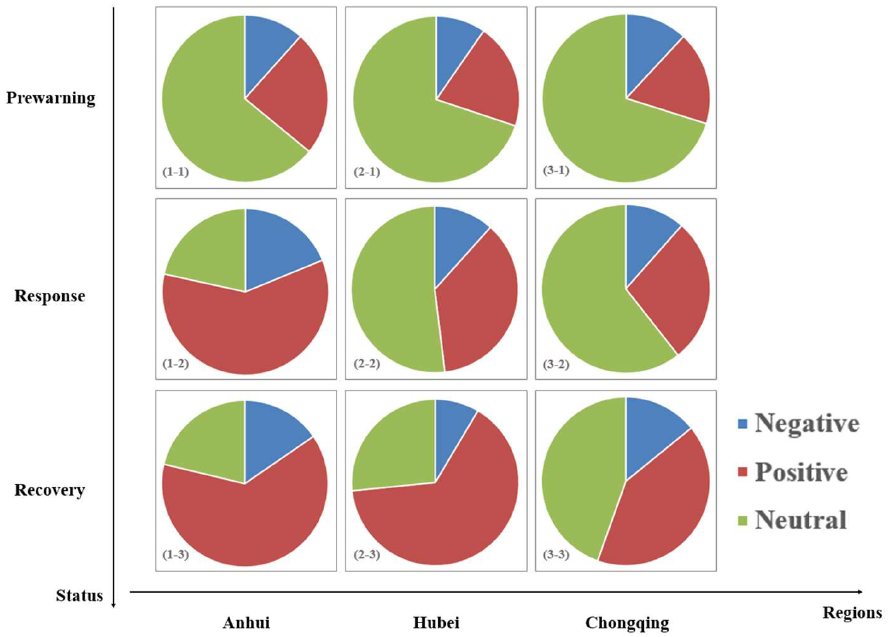
Figure 19. The proportion of different emotions in each status. Row1 represents the prewarning status, Row2 represents the response status, Row3 represents the recovery status, Colum1 represents Anhui, Colum2 represents Hubei, and Colum3 represents Chongqing.